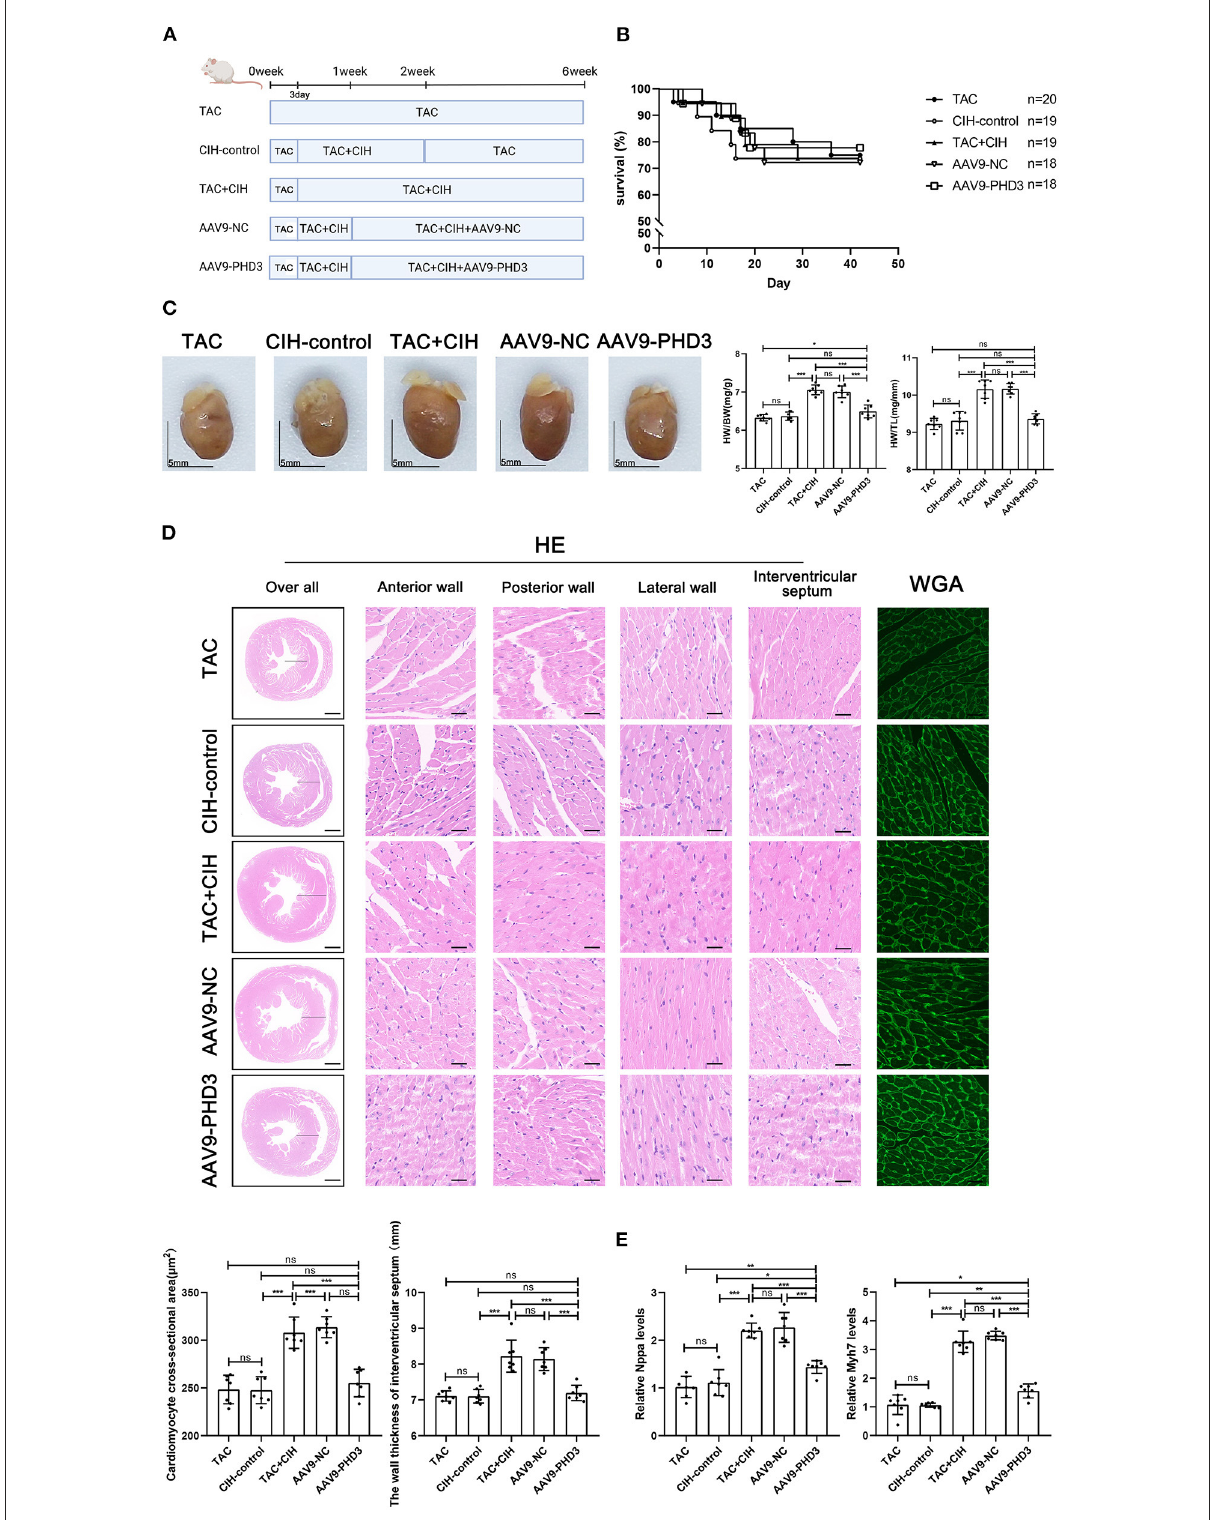
FIGURE5 PHD3 overexpression alleviates the cardiomyocyte hypertrophy induced by CIH exposure. (A) Grouping and experimental protocol for each group. TAC: Transverse aortic constriction surgery was performed, followed by normoxia for 6 weeks; CIH-control: CIH exposure was performed 3 days after transverse aortic constriction surgery and CIH exposure was discontinued at the second week for a total of 6 weeks.